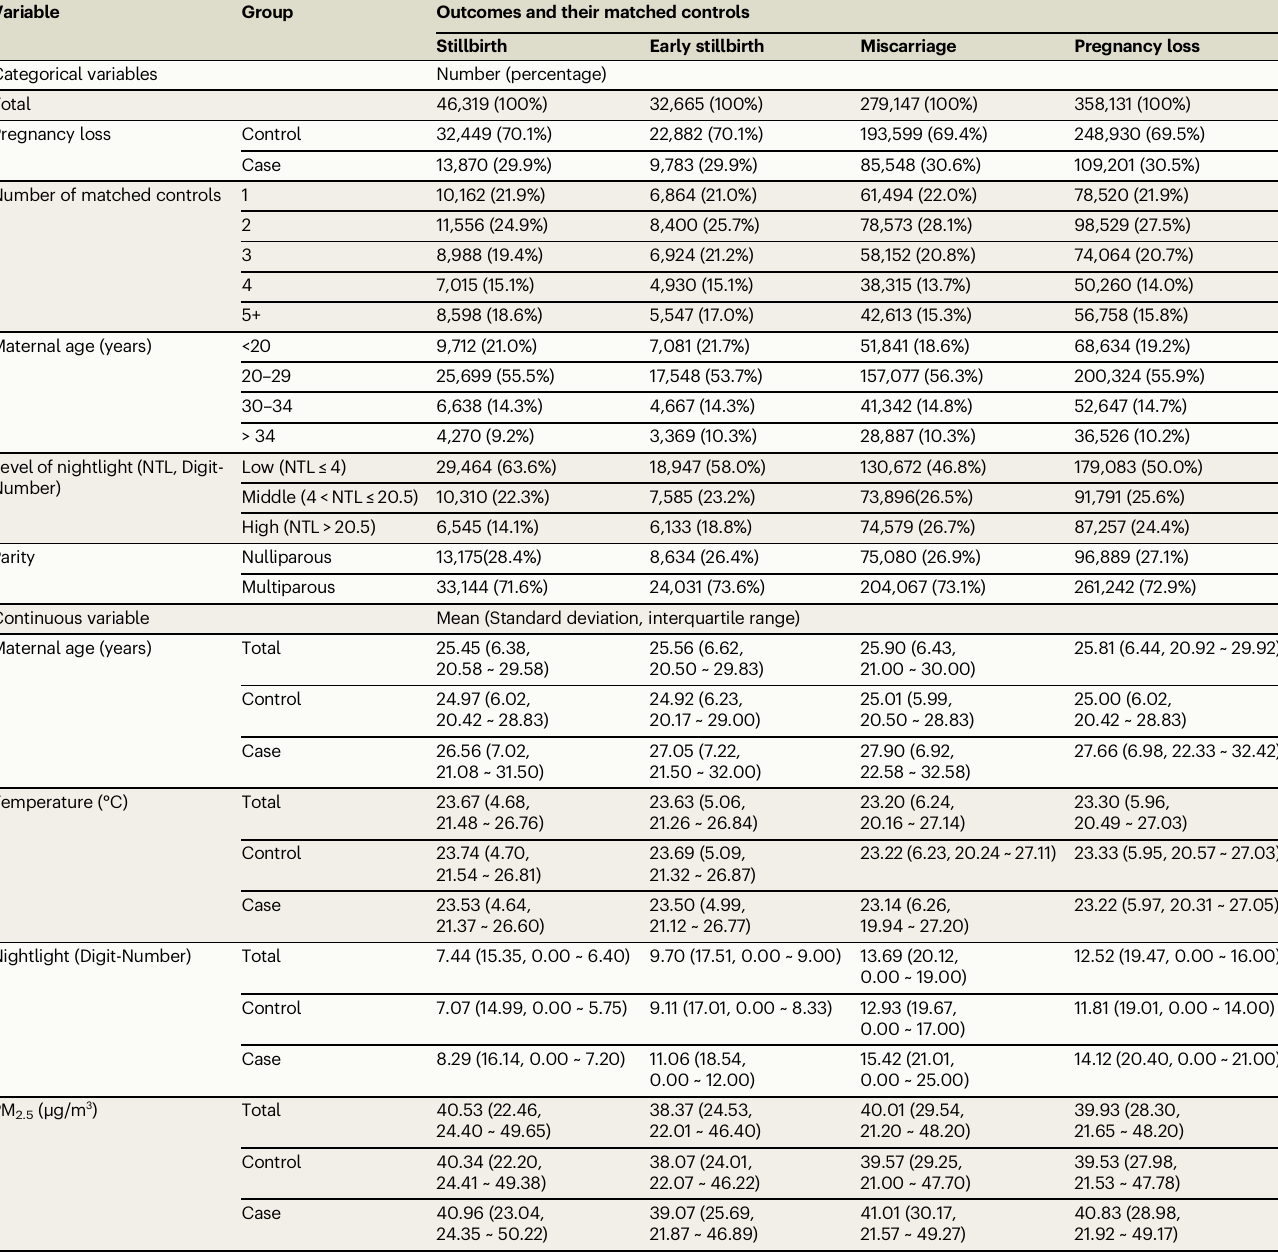
Table 1 | Population characteristics for the dataset used to establish the exposure – response curves between PM 2.5 and stillbirth or other similar outcomes